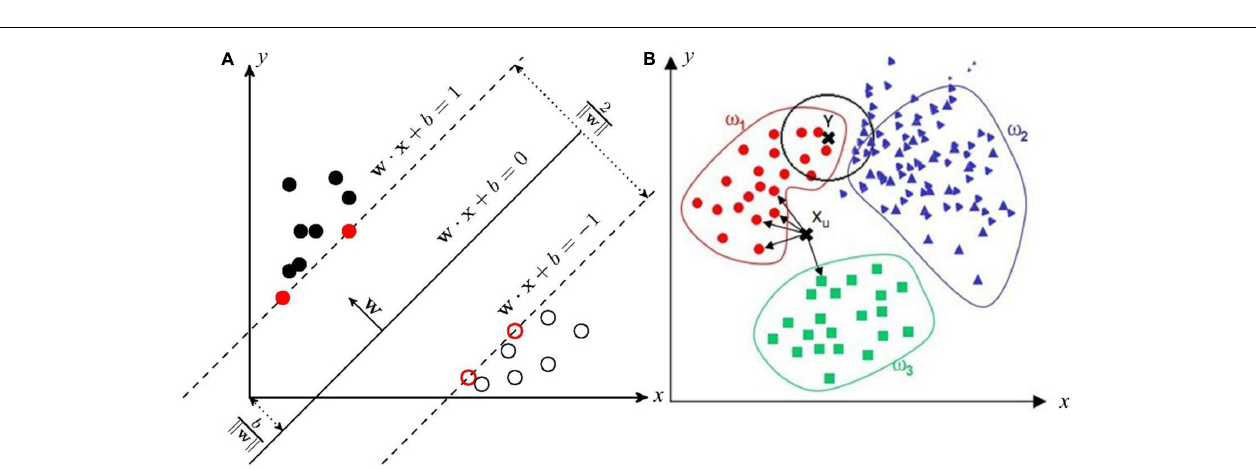
FIGURE 3 | The support vector machine (SVM) and k-nearest neighbor (kNN) method for the fault diagnosis and detection (FDD) in the nuclear power plant (NPP). (A) SVM (B) kNN.